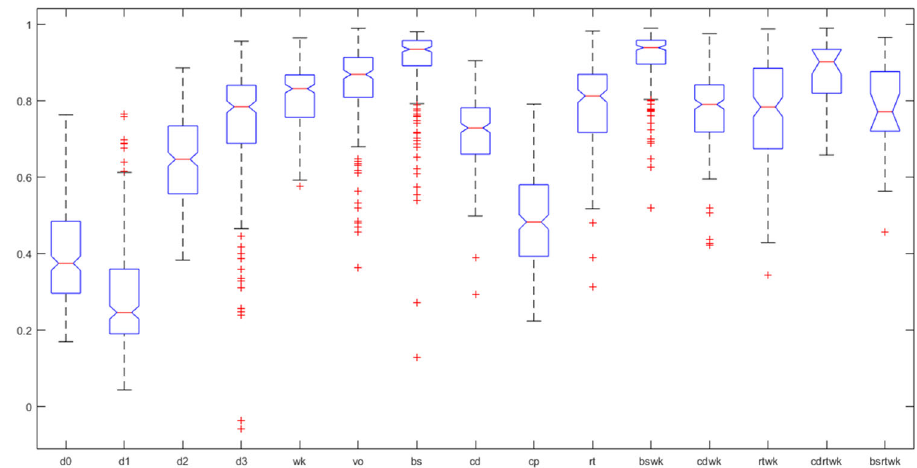
Fig. 5 Boxplot of R 2 -distribution of daily travelled distance according the respective modes of transport. The abbreviations of the modes of transport are: d 0, d 1, d 2, d 3, as de fi ned above, wk — walking, vo — velo or bike, bs — stage bus, cd — car driver, cp — car passenger, rt — rail, and the respective combinations.